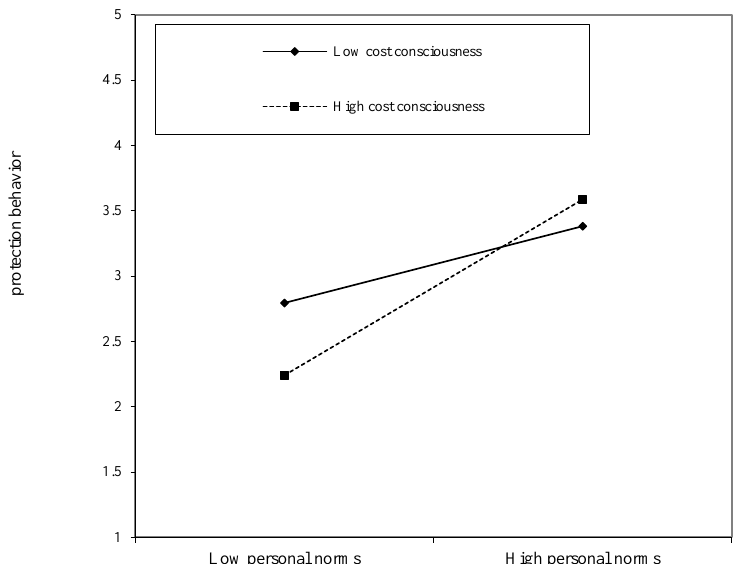
Figure 2. The moderating role of cost consciousness in the relationship between personal norms and environmental protection behavior.